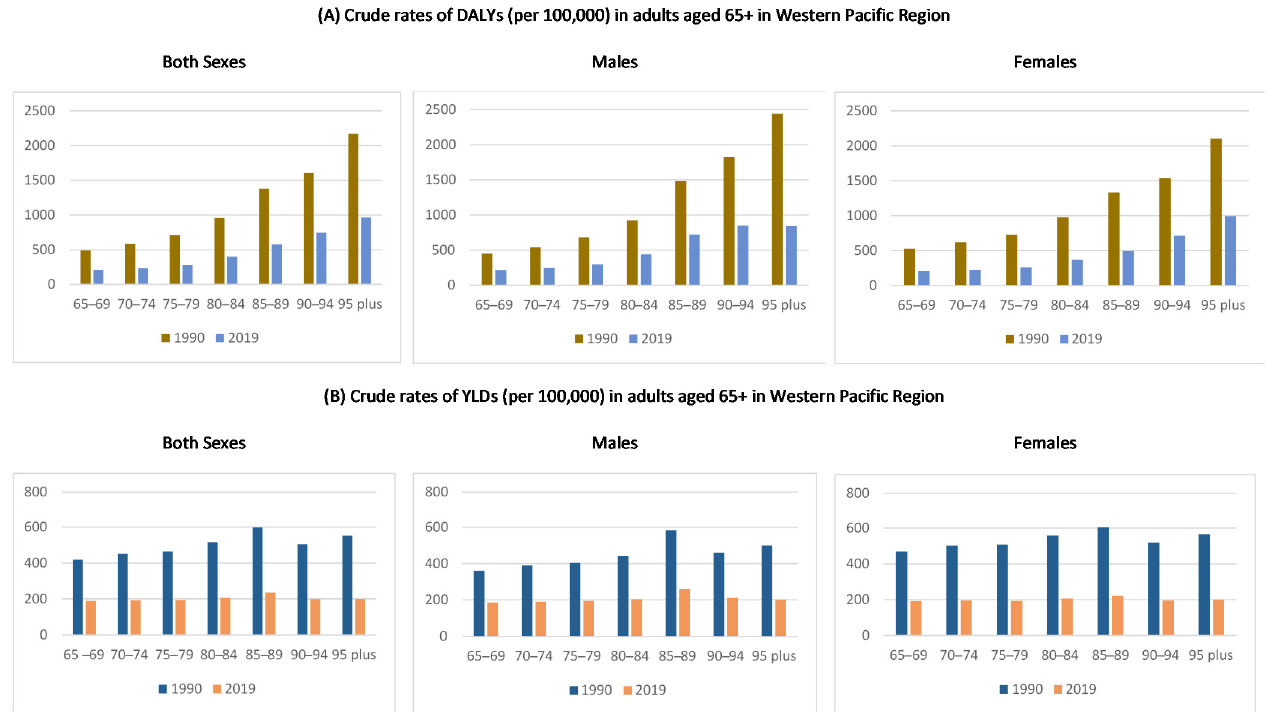
Figure 1. Age-specific ( A ) DALYs, ( B ) YLD crude rate by both sexes, male, and female, in the Western Pacific region from 1990 to 2019. Note: Points in the Y -axis indicate estimates of the rates per 100,000 population.